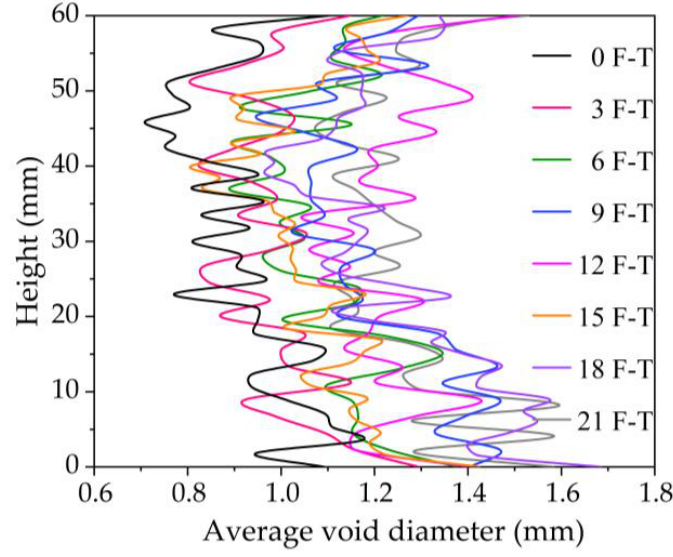
Figure 9. Distribution of internal average void diameter of asphalt mixture under F – T cycles.